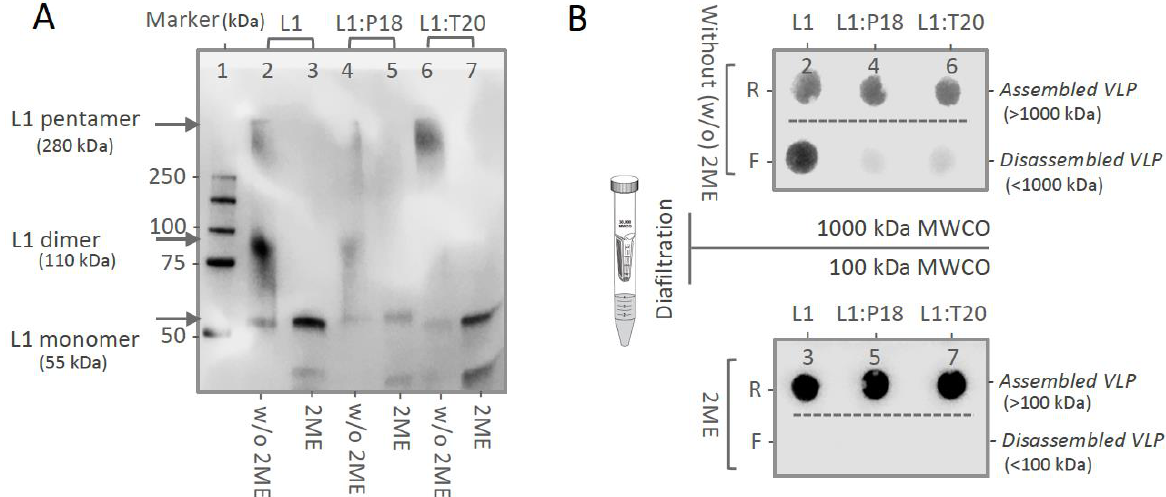
Figure 3. In vitro stability of L1:P18I10 and L1:T20 VLPs. ( A ) Disulfide cross-linking of L1:P18I10 and L1:T20 VLPs in non-reducing SDS-PAGE. The HPV16 L1 VLPs, purified L1:P18I10 and L1:T20 VLPs were mixed with Laemmli sample buffer in the absence or presence of 2-mercaptoethanol (2-ME), respectively, and analyzed by non-reducing SDS-PAGE. The position of the L1 monomer (55 kDa), L1 dimer (110 kDa) and L1 pentamer (280 kDa) are indicated by the arrow. Lane 1: protein molecular weight marker; Lane 2: HPV16 L1 VLP; Lane 3: HPV16 L1 VLP treated with 2-ME; Lane 4: L1:P18I10 VLP; Lane 5: L1:P18I10 VLP treated with 2-ME; Lane 6: L1:T20 VLP; Lane 7: L1:T20 VLP treated with 2-ME. ( B ) Molecular mass analysis of L1:P18I10 and L1:T20 VLPs. Assembled VLPs un-treated with 2-ME (lane 2, 4 and 6) were filtered out through 1000kDa molecular weight cutoff (MWCO) diafiltration devices (upper panel). Disassembled VLPs treated with 2-ME (lane 3, 5 and 7) were filtered out through 100kDa MWCO centrifugal filter devices (lower panel). Retentates (R) were collected from filter device sample reservoirs, while the filtrates (F) were collected at the bottom of centrifuge tubes. The L1 protein signal was detected by using dot blot probed with anti-HPV16 L1